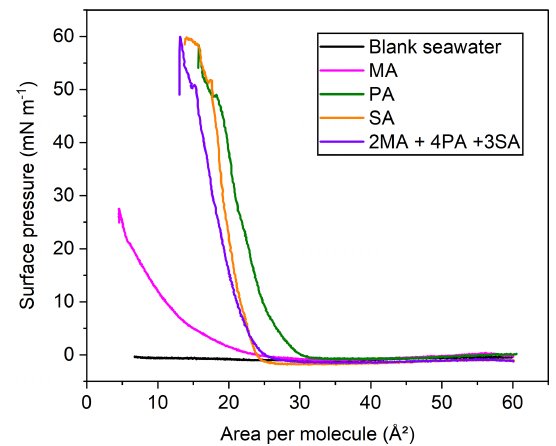
Figure 3. π - A isotherms of myristic acid, palmitic acid, stearic acid, and mixed fatty acids. The black trace represents the back- ground natural seawater solution with no fatty acid